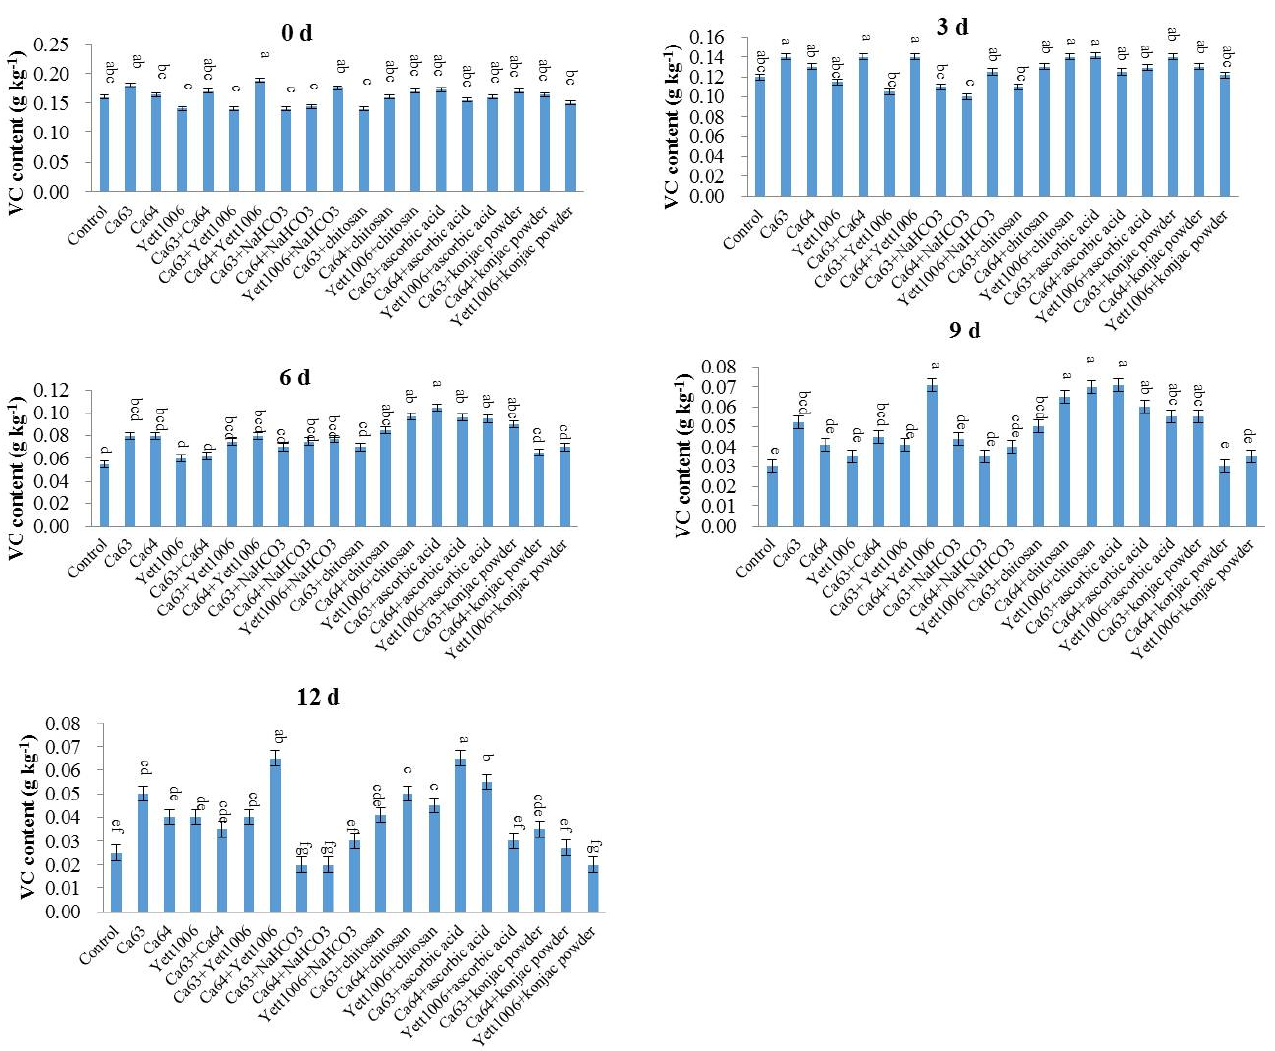
Figure 6. Evaluation of Vitamin C content in snap beans between different treatments. Error bars represent the standard deviations of means ( n = 3). On the bars, the small letters indicate a significant difference in the treatment according to Duncan’s multiple difference test ( p < 0.05).